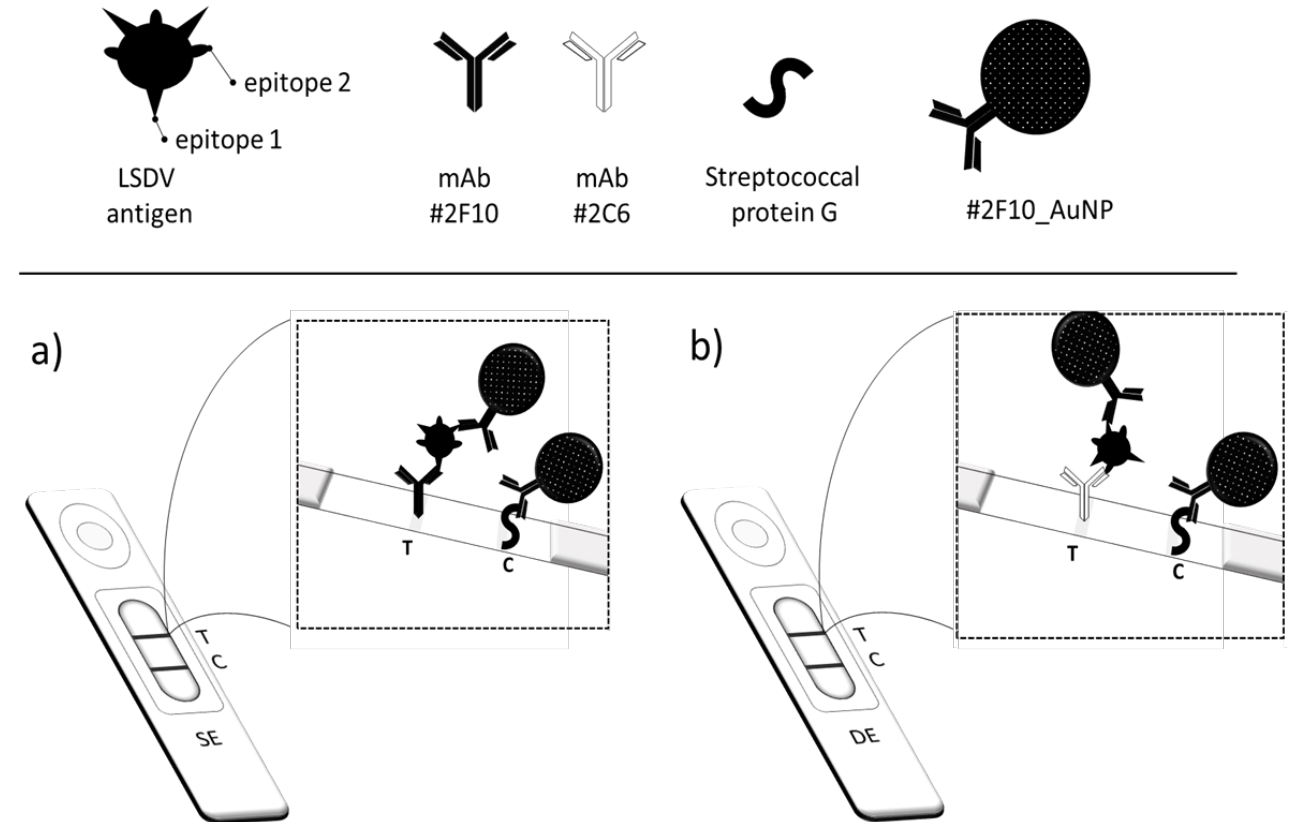
Figure 1. Schematic of the two sandwich-type immunoassays using: one antibody (single epitope, ( a )) and two different antibodies (double epitope, ( b )) as capture and detection.